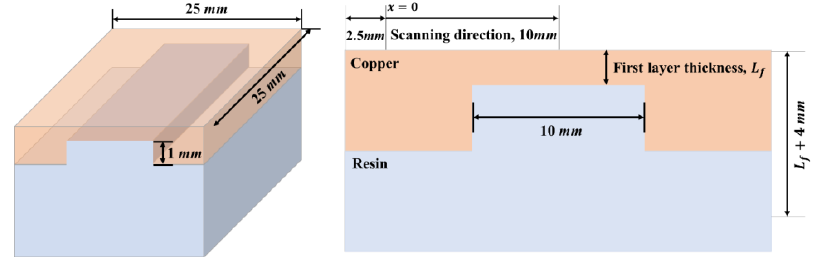
Figure 4. Diagram of specimens used in the numerical analysis and experiment. Table 1. Thermal properties of the materials [23].